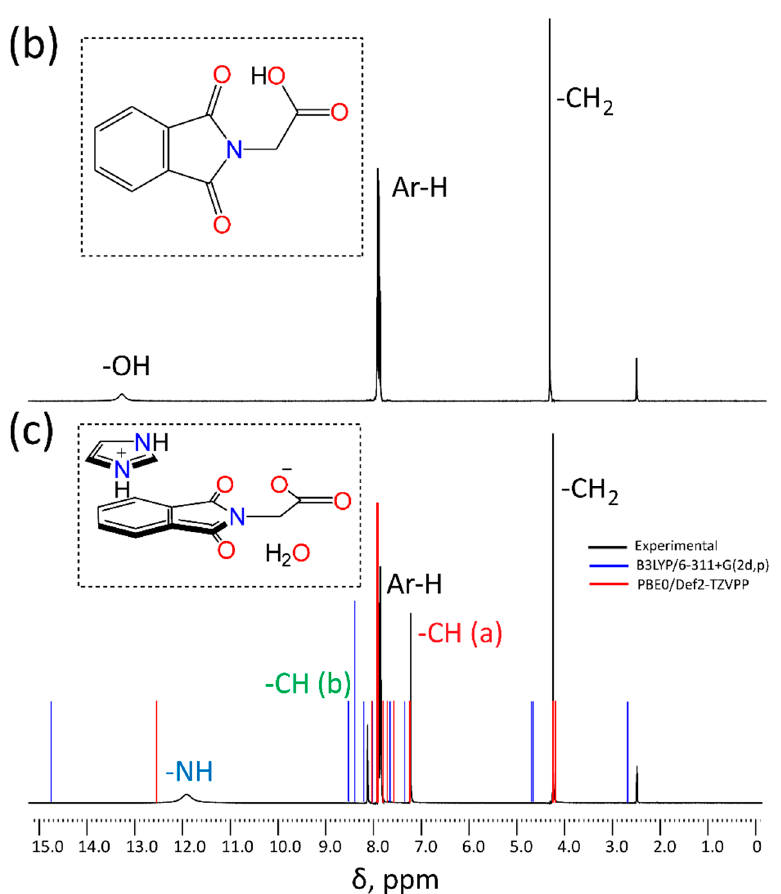
Figure 2. 1 H NMR spectra (in d 6 -DMSO at 295 K) of ( a ) IM, ( b ) NPG, and ( c ) IM + –NPG − –HYD . The DFT calculated chemical shielding (ppm) for IM + –NPG − –HYD protons are shown in blue and red vertical lines.